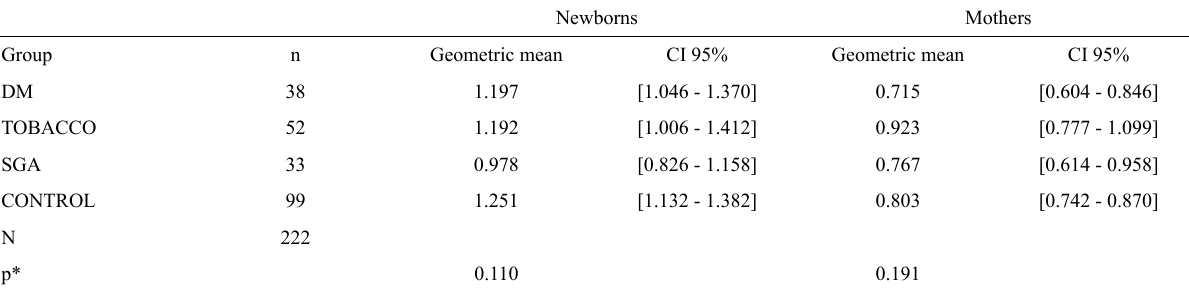
Table 2 – Telomere length (T/S ratio) of newborns and mothers per